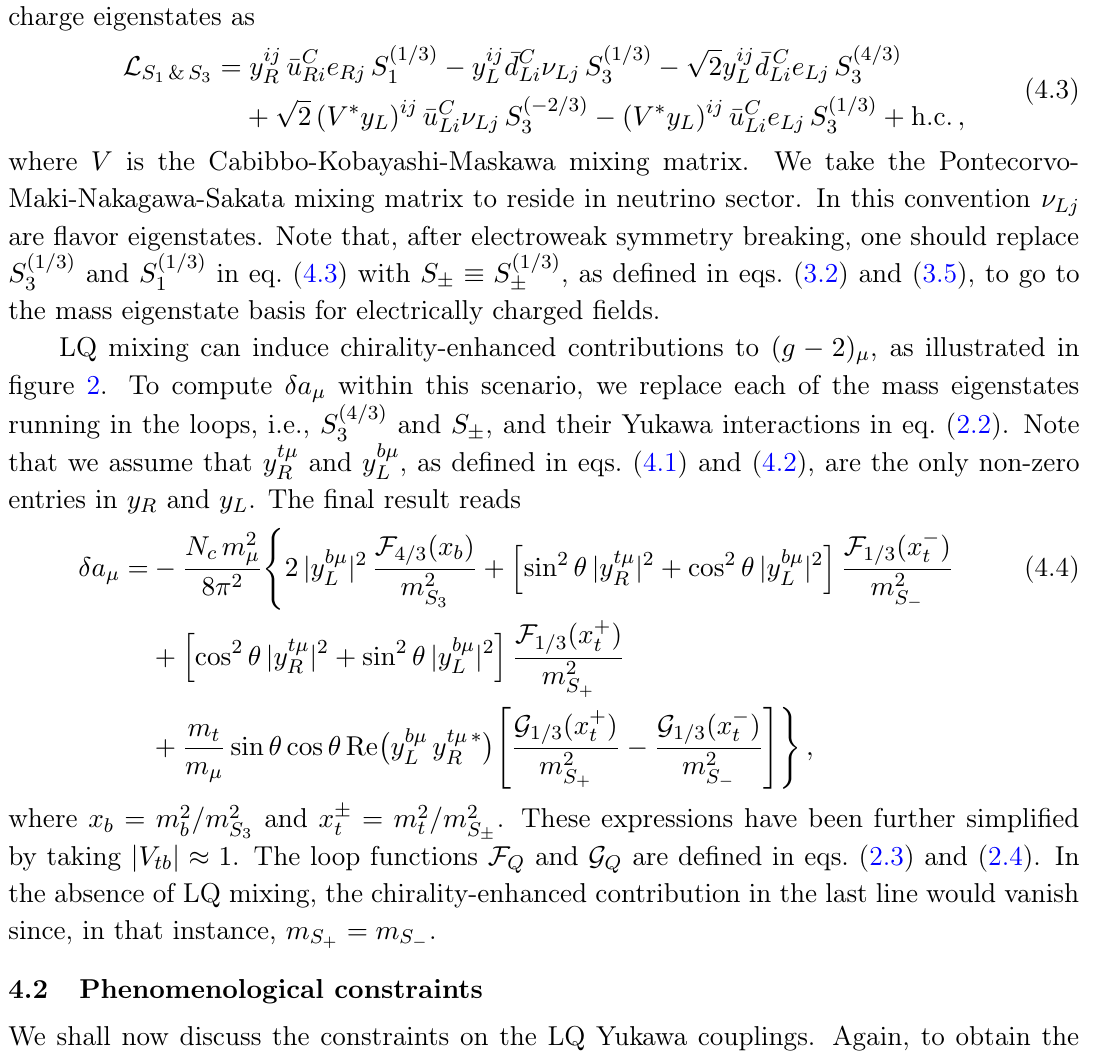
Figure 2 . Illustration of chirality-enhanced contributions to ( g two LQ states S and S 0 that couple to muons of opposite